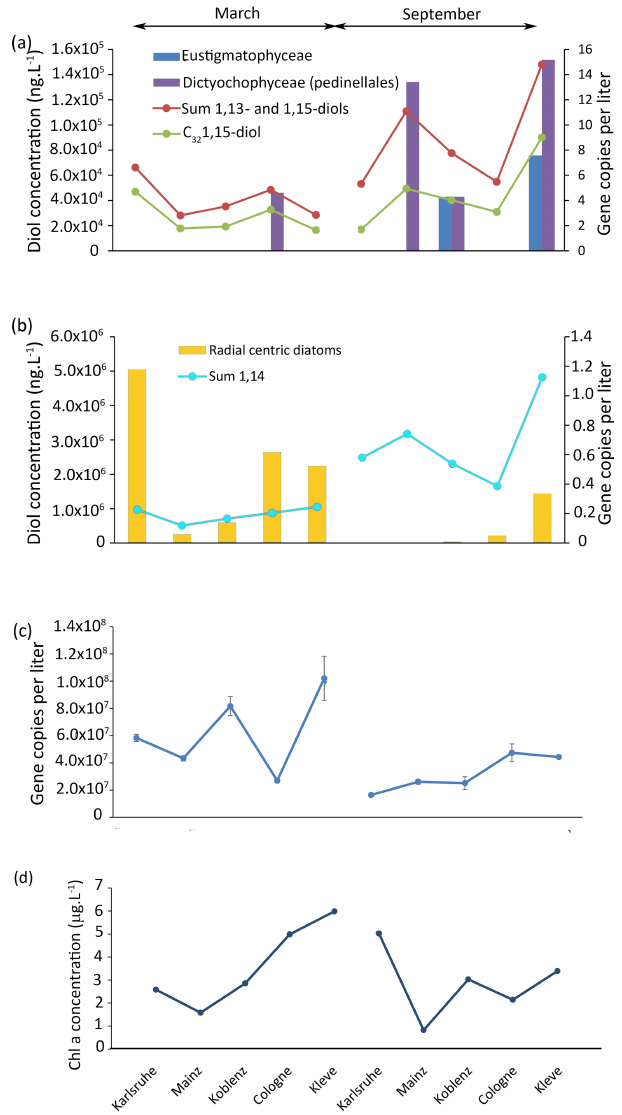
Figure 5. Results of the 18S rRNA analysis of the Rhine water, (a) gene copy per liter of eustigmatophytes and dictyochophytes and concentration of 1,13- and 1,15-diols as well as concentration of the C 32 1,15-diol. (b) Gene copy number per liter of radial centric diatoms and concentration of 1,14-diols. (c) Total gene copy per liter and (d) chlorophyll a